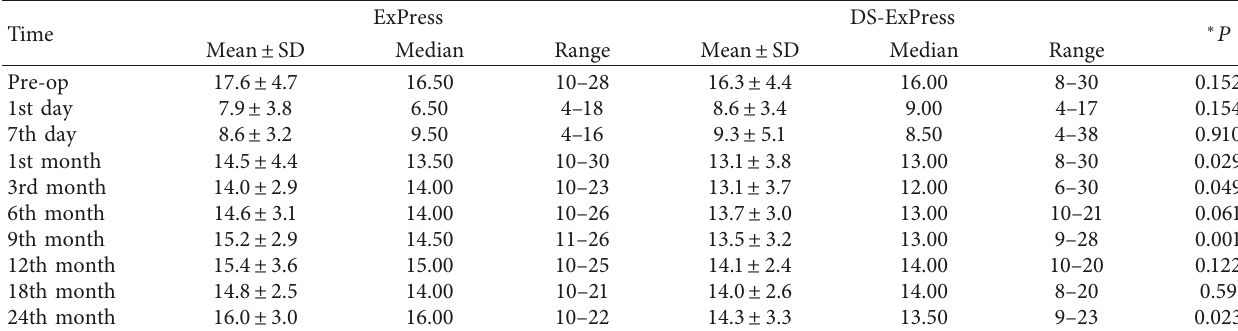
Figure 1: Amount of hypotensive drugs in ExPress and DS-ExPress groups at the end of the observation period (24 Table 2: Intraocular pressure (IOP): mean values, median values, standard deviations, and range in the ExPress and DS-ExPress groups at specific times after surgery.